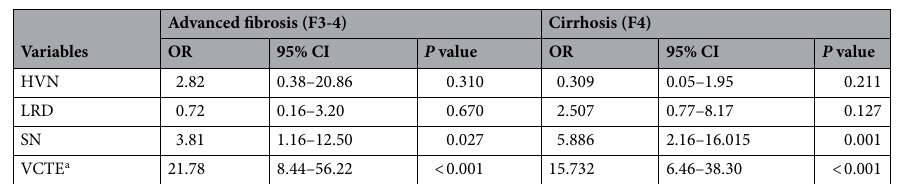
Table 4. Multivariable regression model to assess ultrasound parameters and VCTE for advanced fibrosis and cirrhosis. HVN, hepatic vein nodularity; LRD, lobar redistribution; OR, odd’s ratio; SN, surface nodularity; VCTE, vibration controlled transient elastography. a Liver stiffness measurement ≥ 9.6 kPa for F3-4 and ≥ 10.2 kPa for F4.